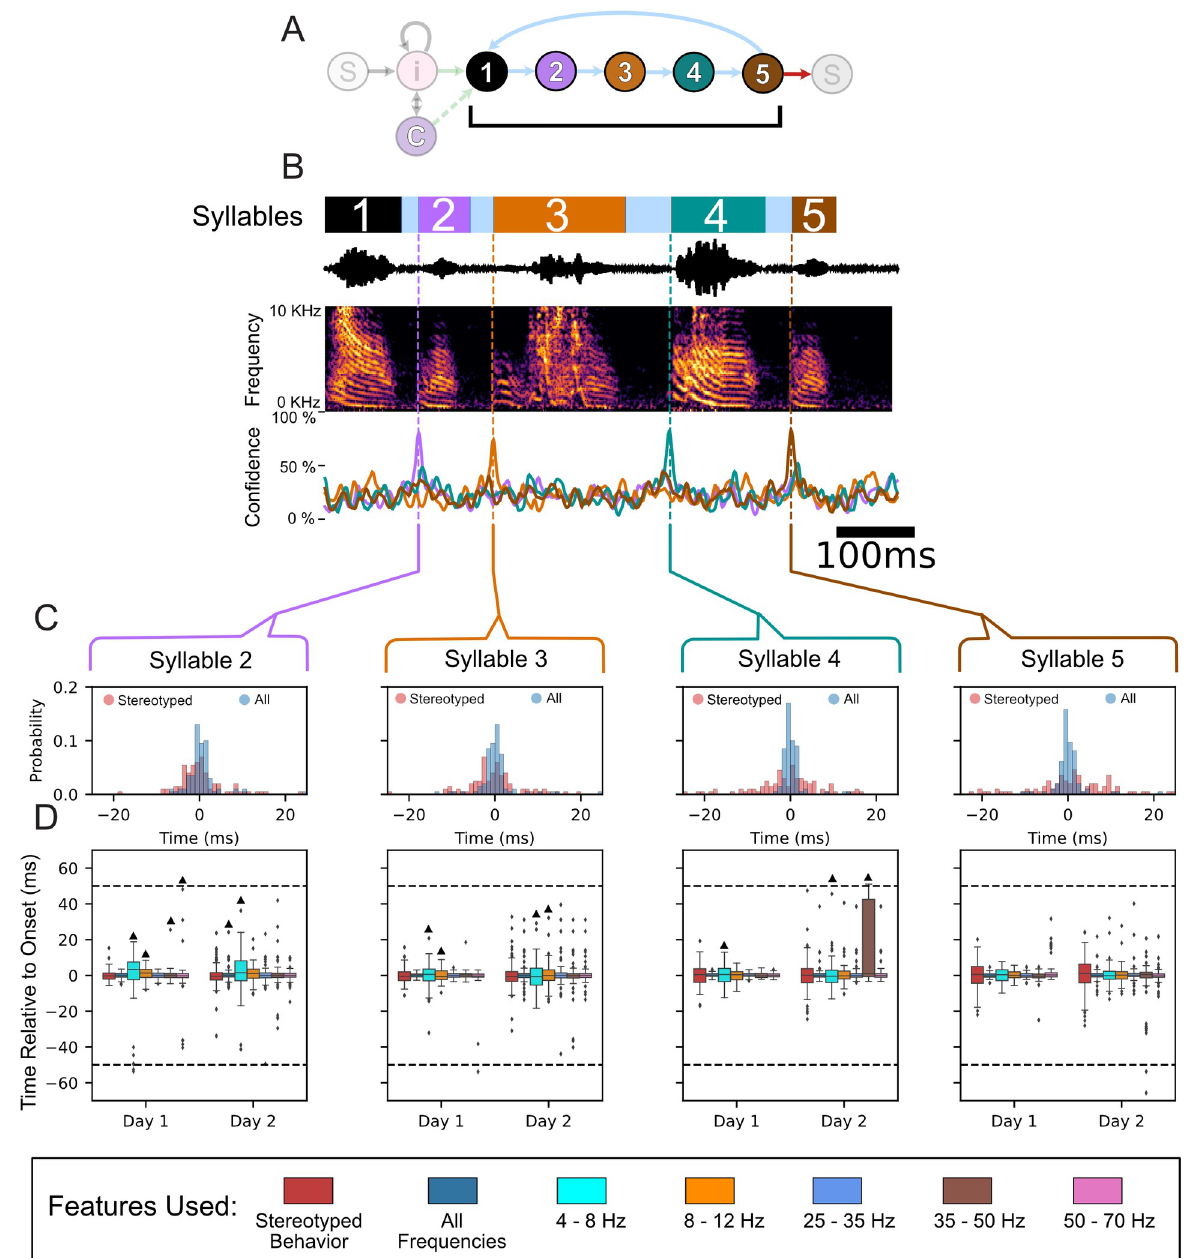
Fig 10. Onset detection using LFP features for Subject z007. (A) State diagram of z007’s observed song structure. Syllable colors are the same as in Figs 2 and 3 . (B) Example motif from the highest-yield day for subject z007. Annotated behavior (top) using the same color scheme as in Fig 2 , sound pressure waveform and the corresponding time-aligned spectrogram (middle), and the time-varying na ï ve confidence of the onset prediction (bottom) for each syllable in this example motif. Confidence signal traces are the same color as the syllable they are meant to predict. (B) Histogram of onset prediction times for each syllable relative to its annotated start time. The annotated start times are relative to the start of the first syllable of the motif that the syllable occurred in. The histogram compares two approaches: The first, in pink, uses only behavioral information (the stereotyped onset relative to the start of the first syllable), and the second, in blue, uses all the neural features to predict the start of the syllable. (C) Boxplot of onset prediction times relative to the labeled onset time for both of the high-yield days for z007. The order of each feature used is the same, going left to right: first is the stereotyped onset time using only the deterministic behavior (colored red), next are the results using all of the neural features (colored navy blue), then each frequency band only in order from least to greatest (4–8 Hz, 8–12 Hz, 25–35 Hz, 35–50 Hz, and 50– 70 Hz). The time window that the neural based predictor must make a prediction within is represented by the dotted black line represents (see Methods). Statistical significance was calculated using the one sided Wilcoxon signed-rank test, and ▲ denotes results that are not statistically significant when using the Benjamini-Hochberg False Discovery Rate. All other results p < 0.05 and q < 0.05.